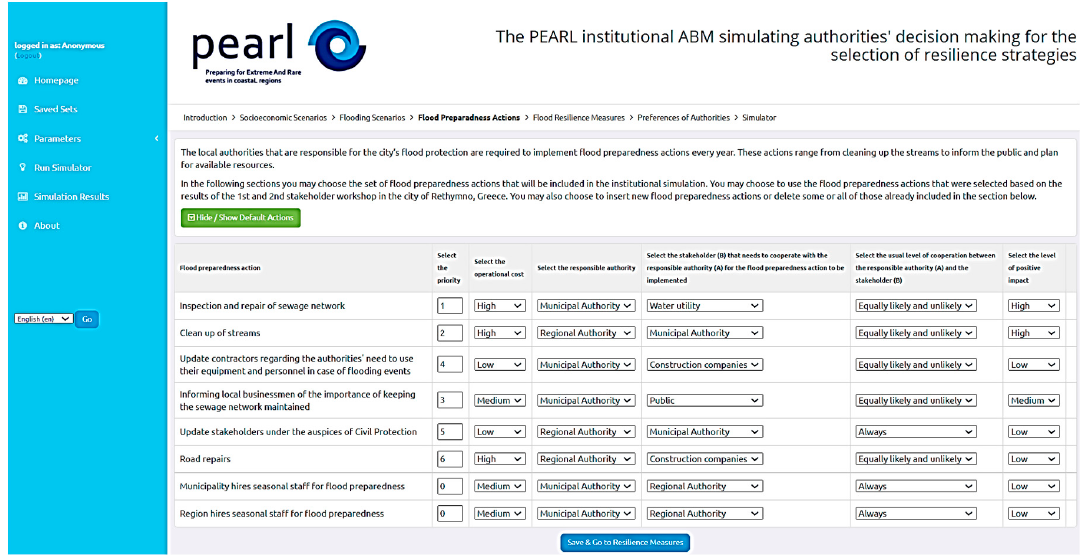
Figure 9. Choose flood preparedness actions and their characteristics.